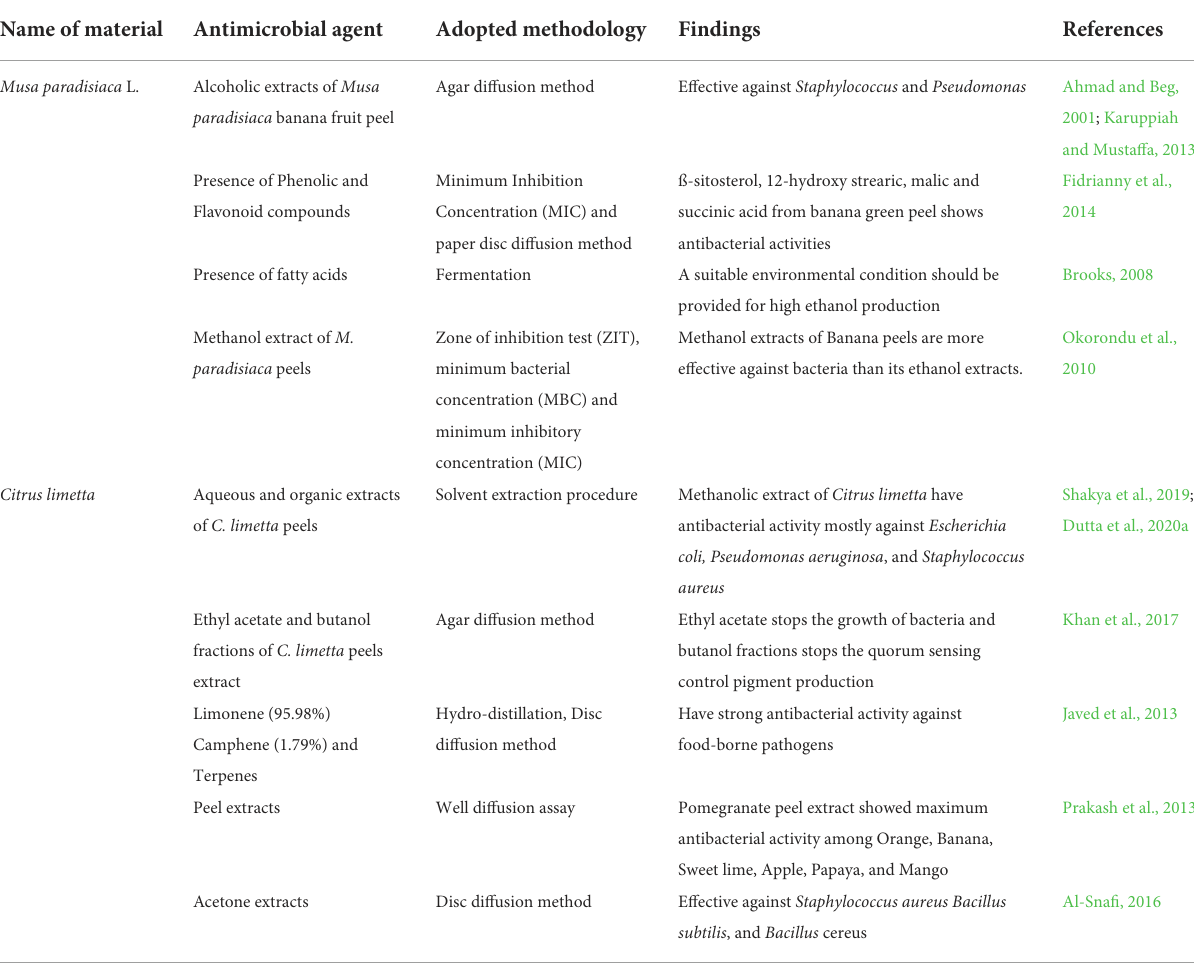
TABLE 2 Musa paradisiaca L. and Citrus limetta as an antimicrobial agent. Name of